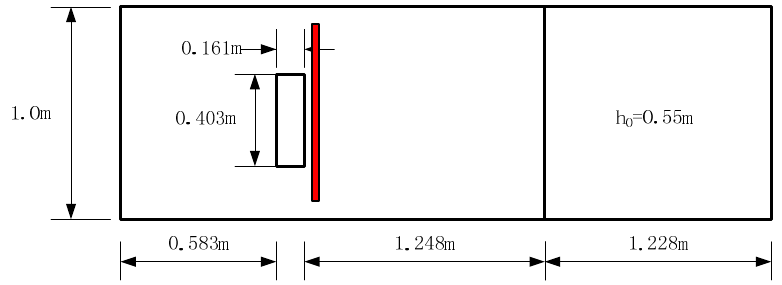
Figure 11. Area of particle splitting for dam break case [21], coordinated from (0.75, 0.2) to (0.8, 0.8).